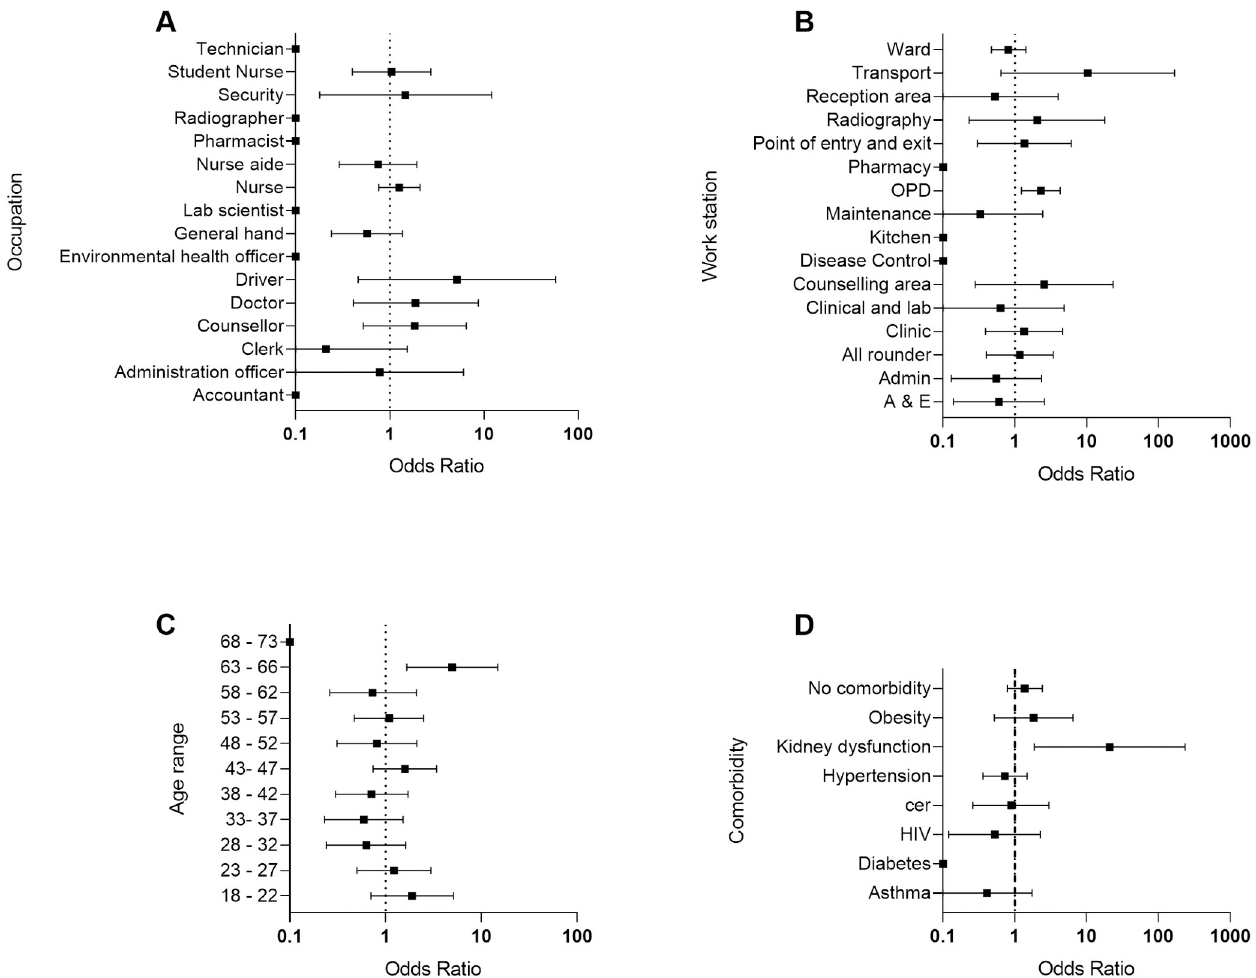
Fig 6. Odds ratio for sero-reactivity. A) Partitioned by occupation. B) Partitioned by workstation. C) Partitioned by age group. D) Partitioned by self- reported co-morbidities.